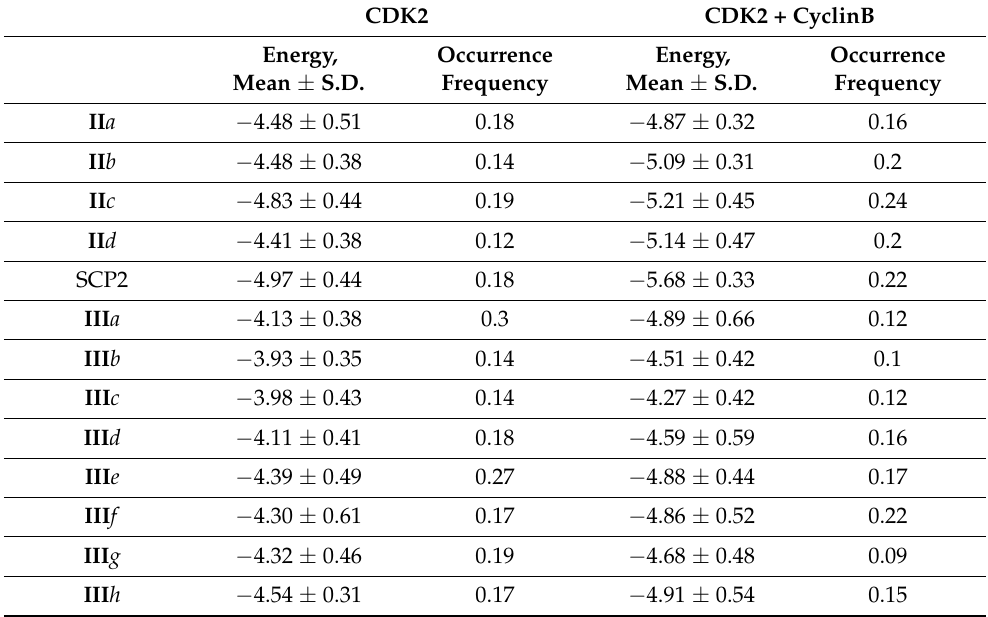
Figure 12. Chosen cluster location for the CDK2 variant 5fp5. Brown: centroids of the receptor residues. Blue: centroids of the docked molecules. Table 5. Affinity of the synthesized compounds for the CDK2 crystal variants. AutoDock Vina data for the most occupied cluster on the protein